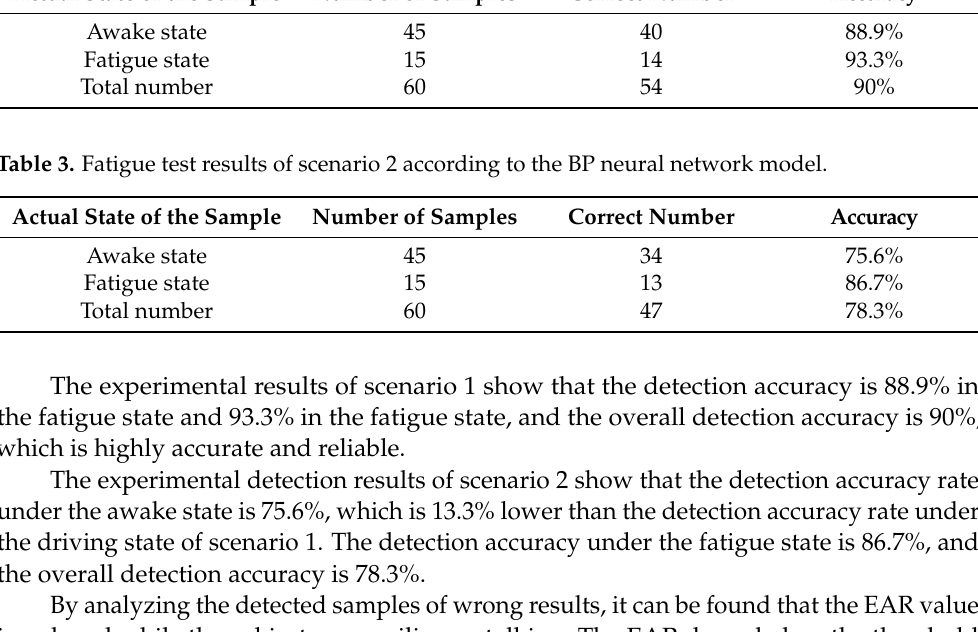
Table 2. Fatigue test results of scenario 1 according to the BP neural network model. Actual State of the Sample